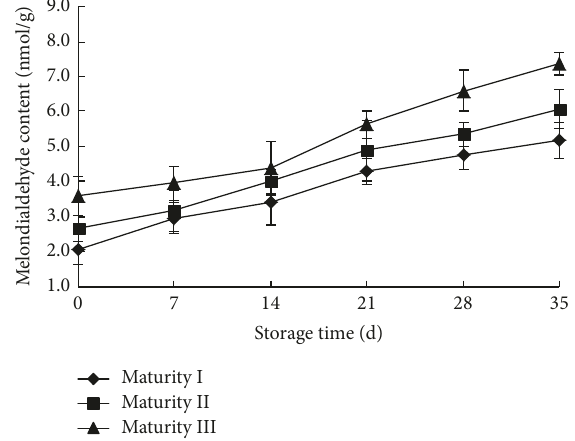
Figure 10: Effects of harvest maturity on malondialdehyde content in apricots; fruits with maturity class I (colored area < 50%), maturity class II (colored area 50–80%), and maturity class III (colored area > 80%) were categorized according to the yellow conversion rate. Vertical bars represent the standard errors of the means of triplicate